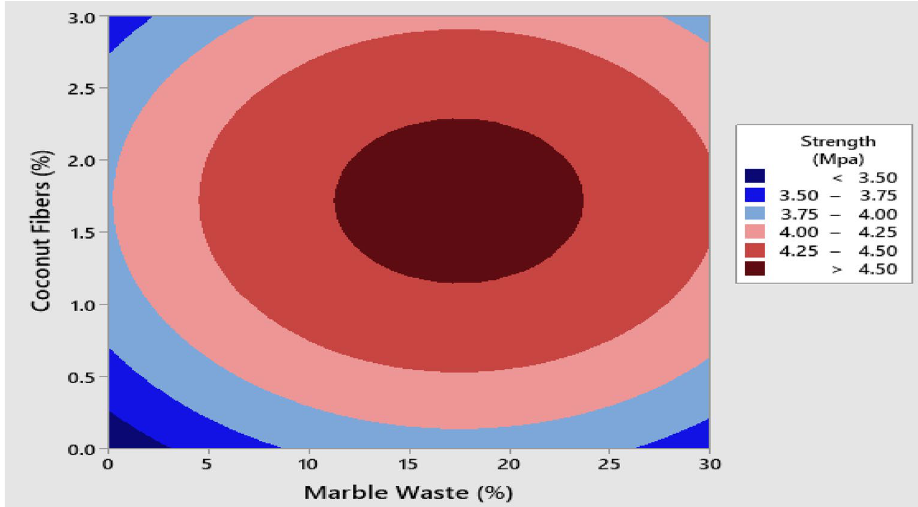
Figure 27. Contour plot for pull out/bond